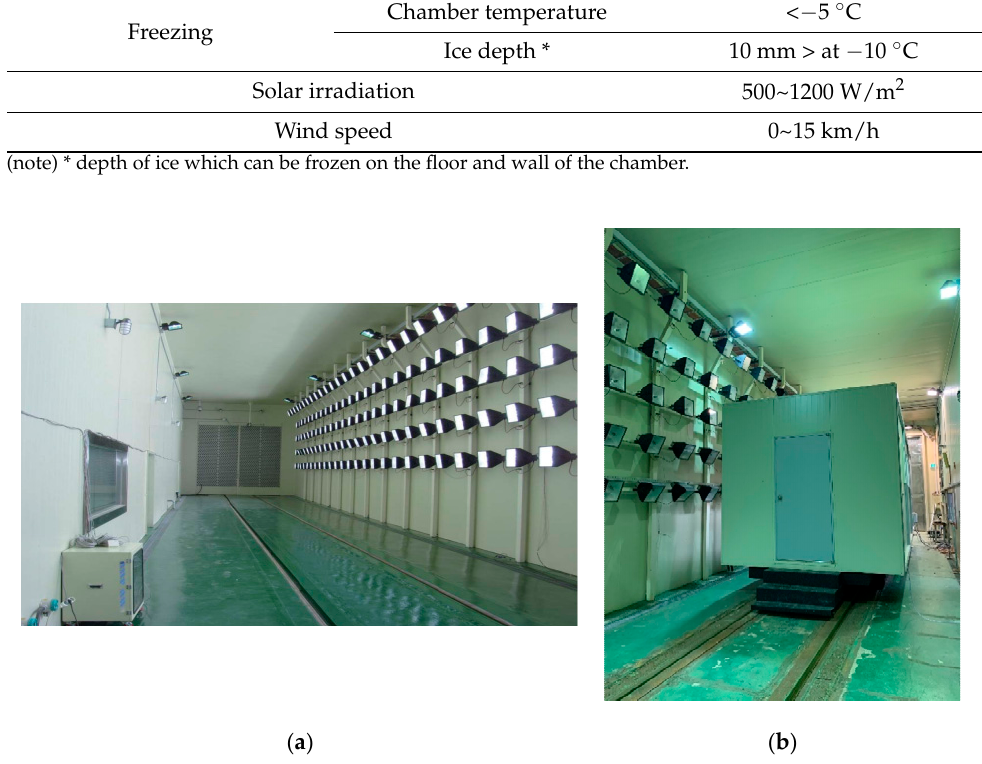
Table 2. Operating specifications of real-scale environmental chamber.